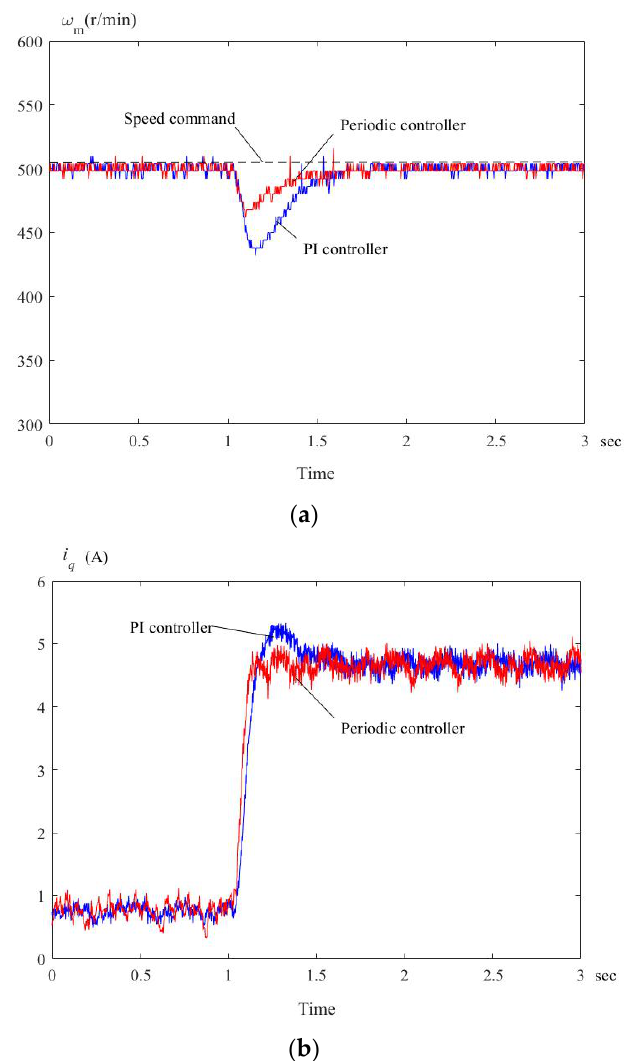
Figure 11. Measured results at 500 rpm and 3.5 N∙m load: ( a ) speed responses; ( b ) q -axis currents.